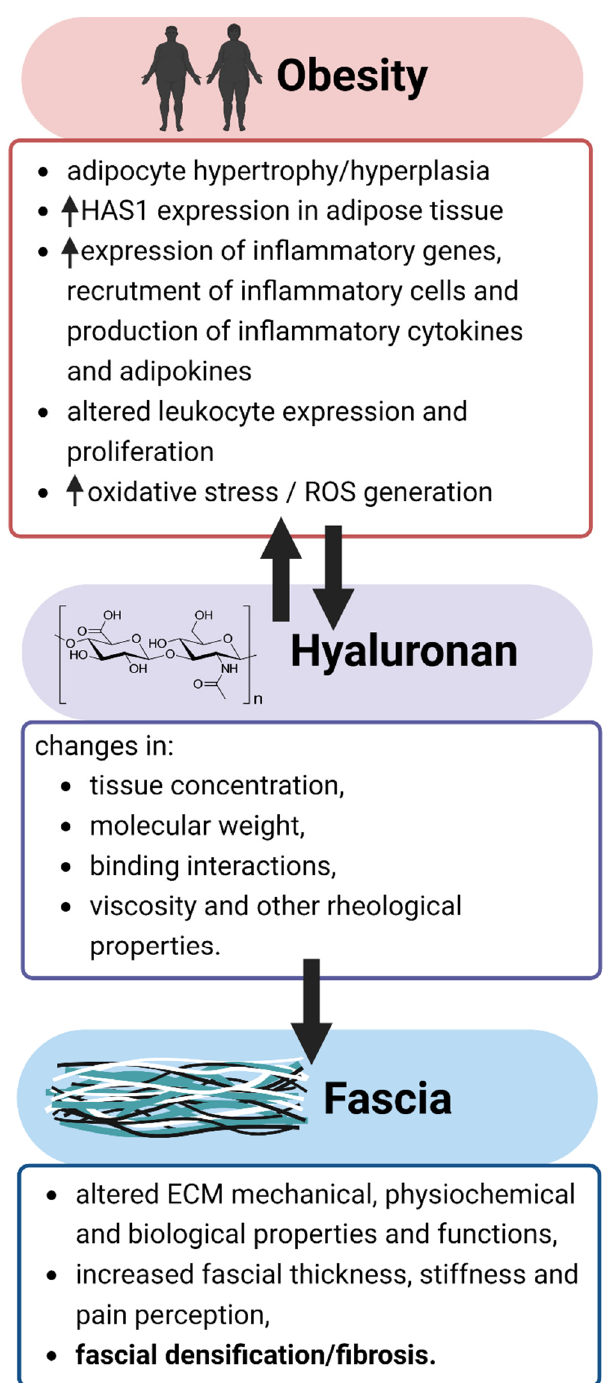
Figure 1. Relationships of pathophysiological mechanisms in obesity with changes in hyaluronan properties and the development of myofascial disease. ECM: extracellular matrix; HAS1: hyaluronan synthase 1; ROS: reactive oxygen species.